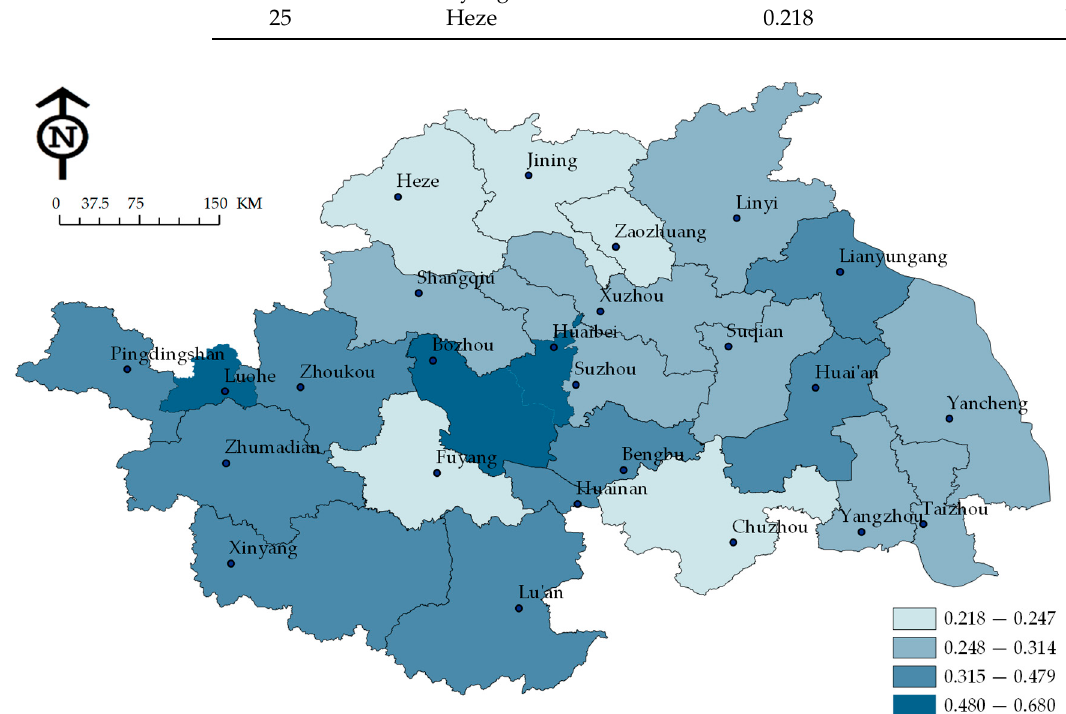
Figure 4. Grading results based on the calculated resource and environment carrying capacity.